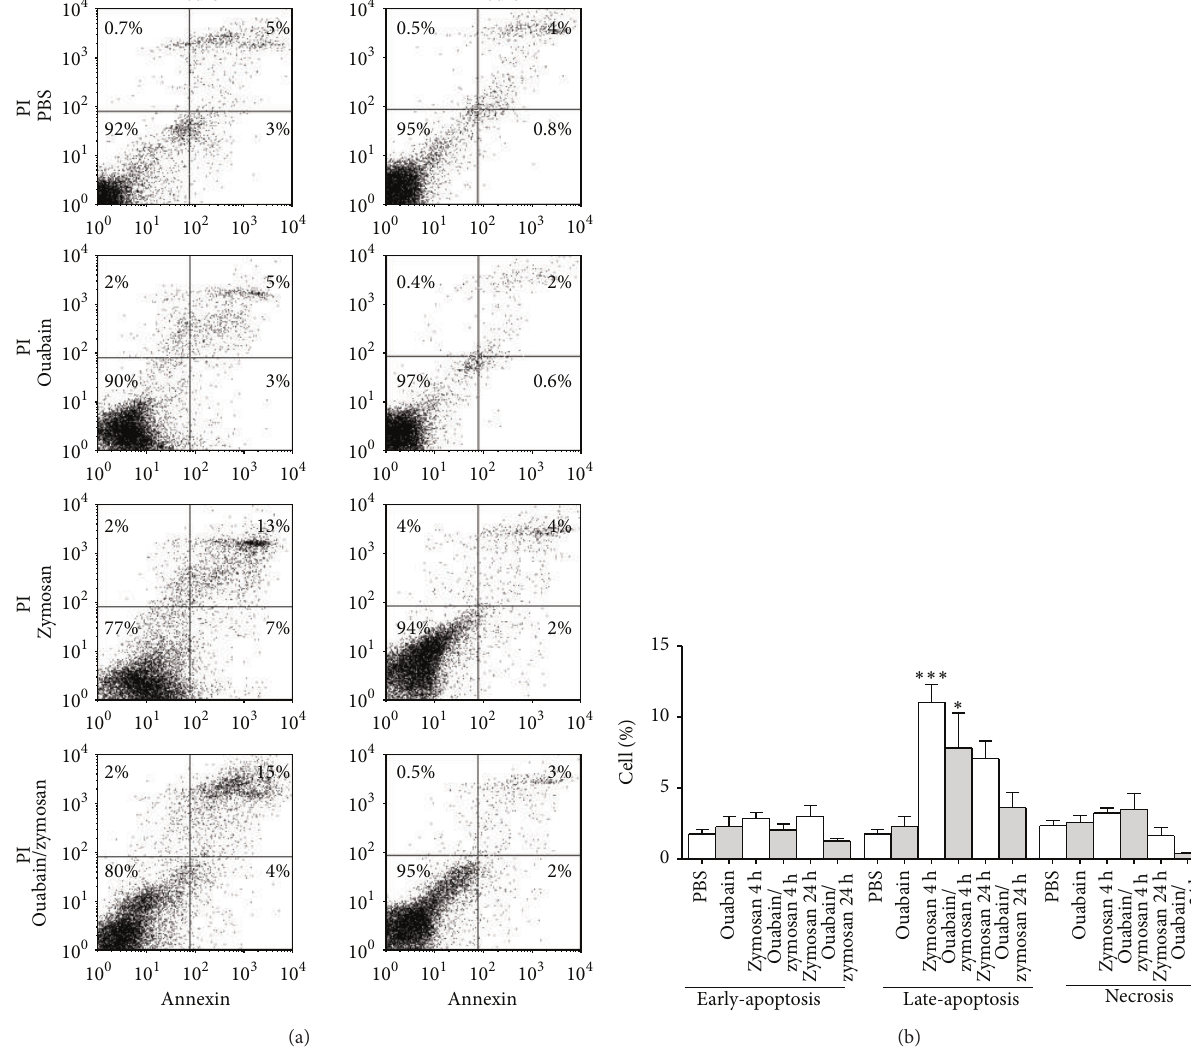
Figure 5: Effect of ouabain on peritoneal leukocytes viability. Viability of the leukocytes present in peritoneal lavage was assessed by flow cytometry. For that, cells obtained by peritoneal lavage were stained with Annexin V and propidium iodide in order to evaluate the percentage of cells undergoing apoptosis and necrosis, respectively. (a) Representative dot plots showing the percentage of cells undergoing initial apoptosis (Annexin V + ), late-apoptosis (Annexin V + and PI + ), and necrosis (PI + ). (b) Data were expressed as mean ± SEM and